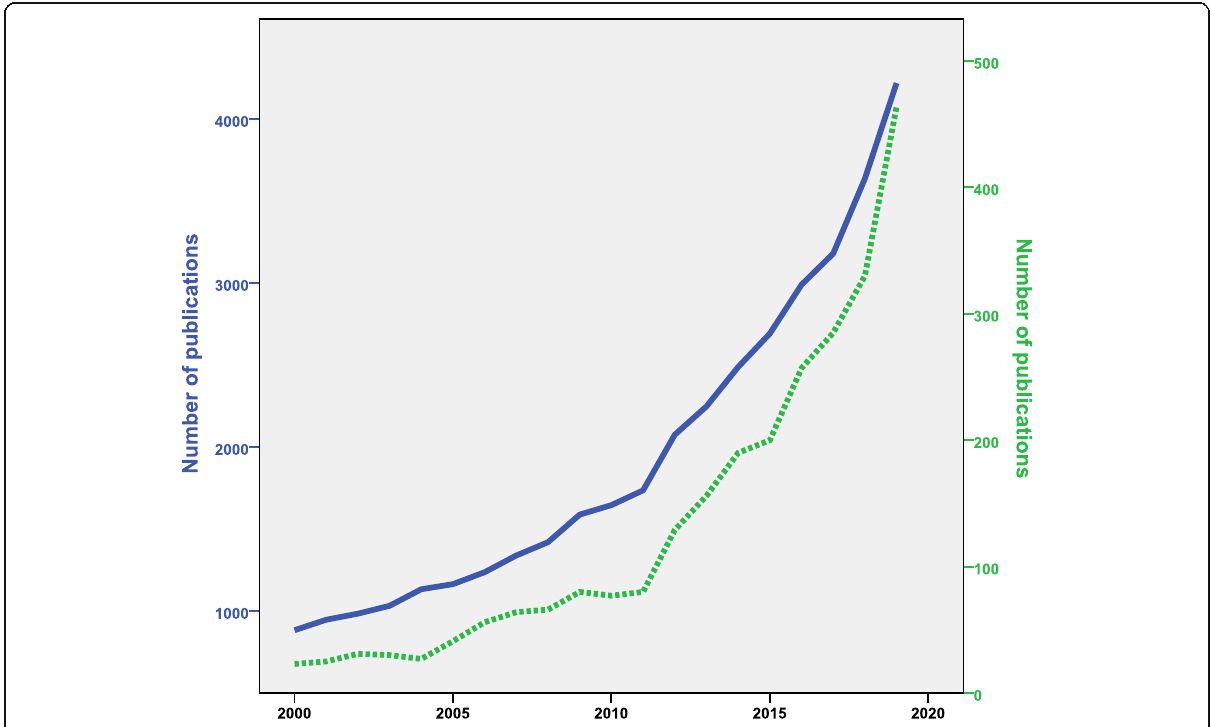
Fig. 1 Annual growth of publications on antimicrobial resistance in the environment. The dashed green line represents the annual growth of AMR in the environment while the blue line represents the annual growth of publications on AMR in